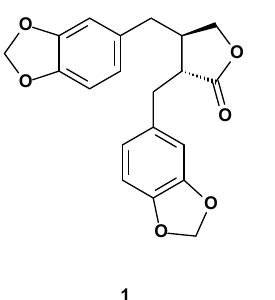
Figure 2. Hinokinin’s